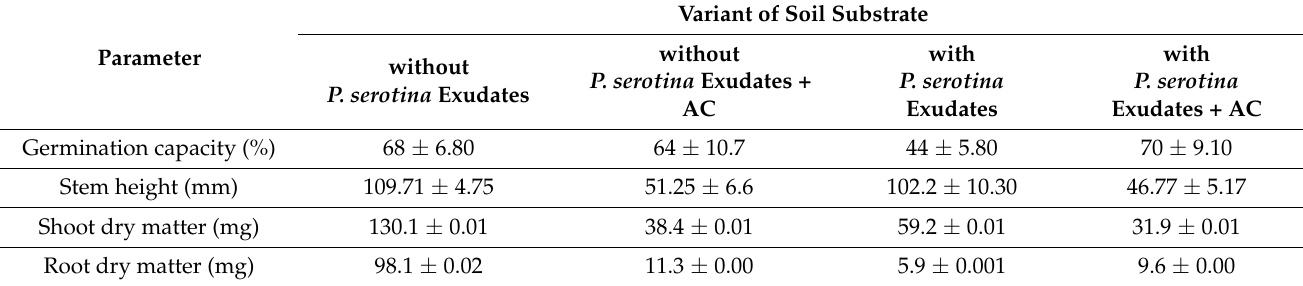
Table 3. Effect of different variants of soil substrate on germination and seedling growth of Sinapis alba in pots. Data are mean ± SE, n =